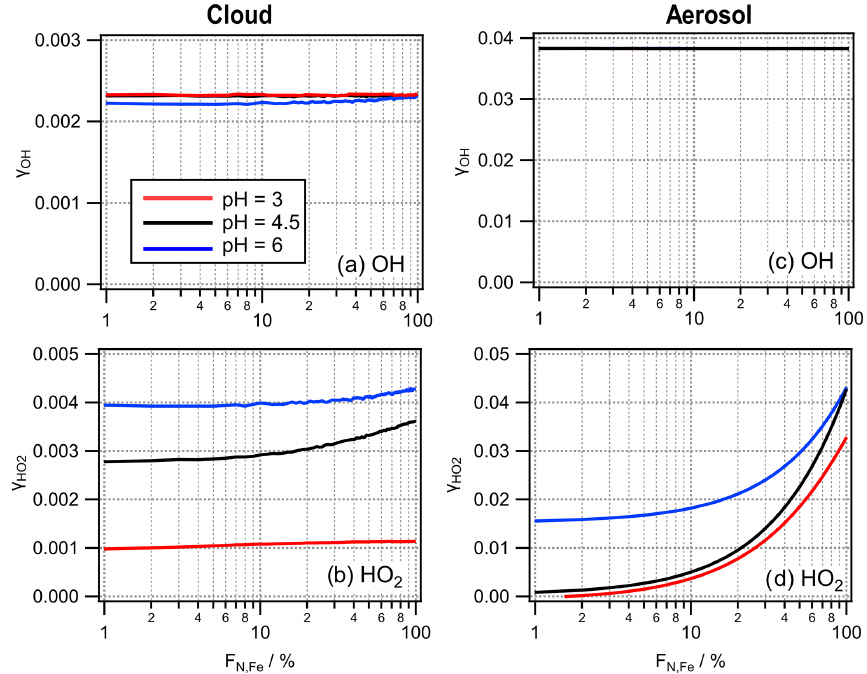
derived from the multiphase model studies at three pH values for (a, b) cloud and (c, 2